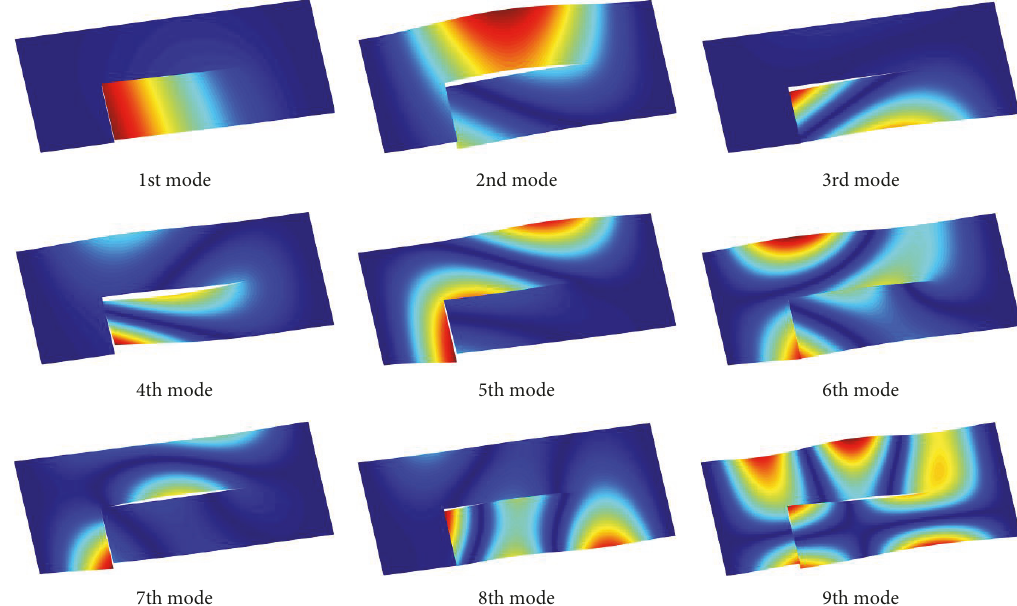
Figure 9: The first nine mode shapes of the FCFC plate with L-shaped